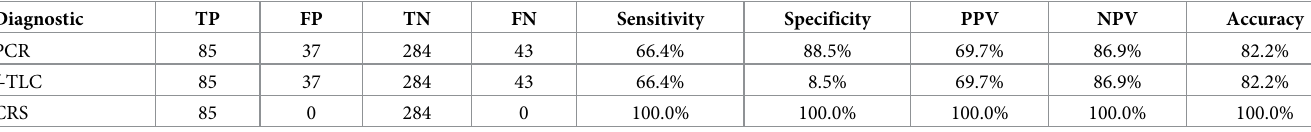
Table 4. Sensitivity, specificity, PPV, NPV, accuracy, and likelihood ratio of f-TLC compared to